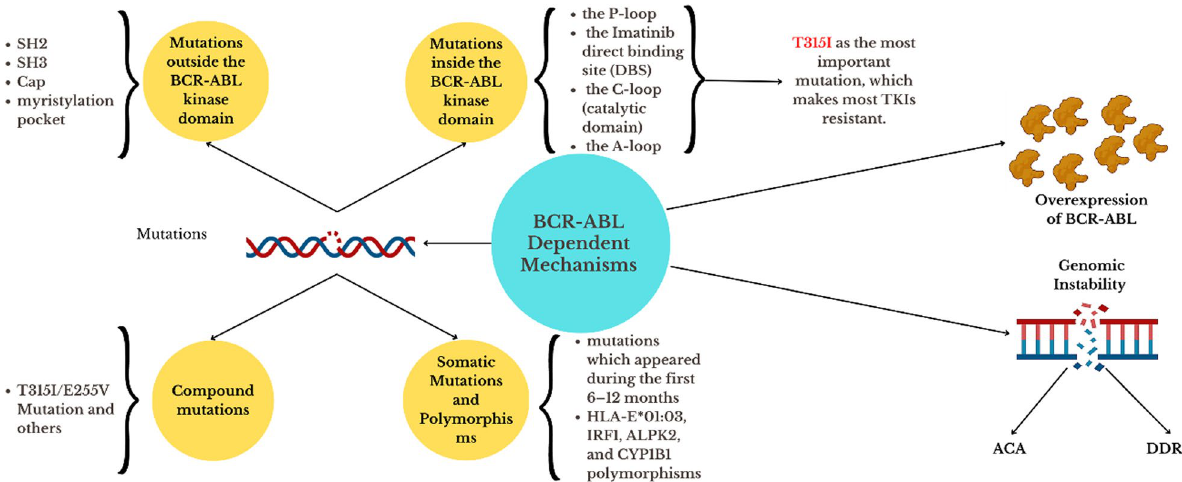
Fig. 2 BCR-ABL-dependent mechanisms, in addition to mutations within the BCR-ABL gene and other proteins, combined mutations, and polymorphisms, overexpression of the BCR-ABL protein, and genomic instability are all contributing factors to this mechanism. Abbreviation SH2, Src homology 2; SH3, Src homology 3; Cap, cysteine-rich secretory proteins; antigen 5; and pathogenesis-related 1 proteins; IRF1, Interferon regulatory factor 1; ALPK2, Alpha Protein Kinase 2; and CYP1B1, cytochrome P450 1B1; ACA, additional chromosomal aberrations; DDR, DNA damage response